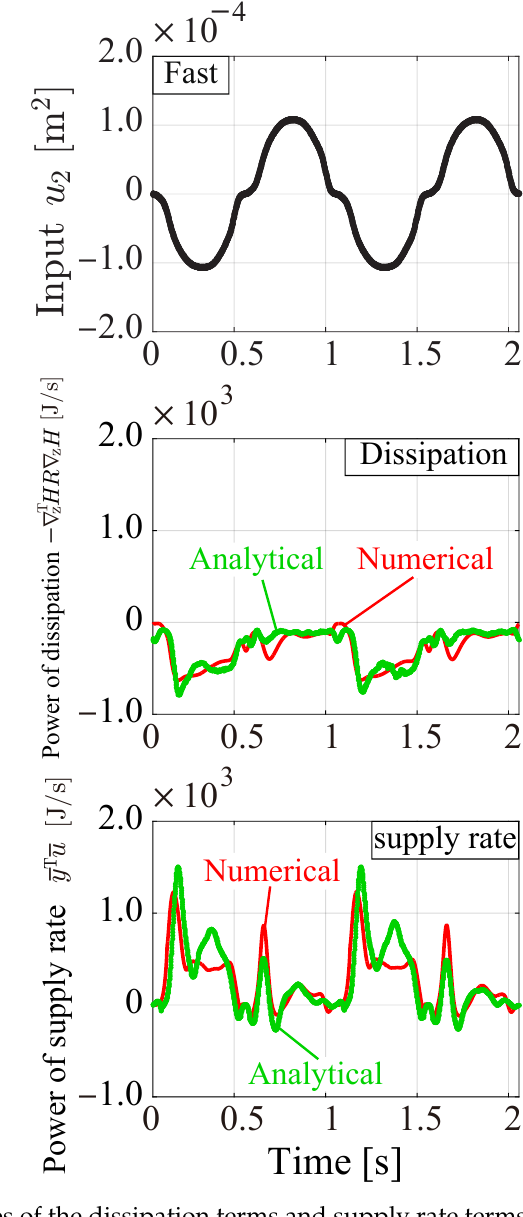
Figure 11. Numerical (red) vs. analytical (green) time responses of the dissipation terms and supply rate terms of the time derivative of the Hamiltonian. (Energy behavior analysis, slow: f = 0.5 [Hz], fast: f = 1.0